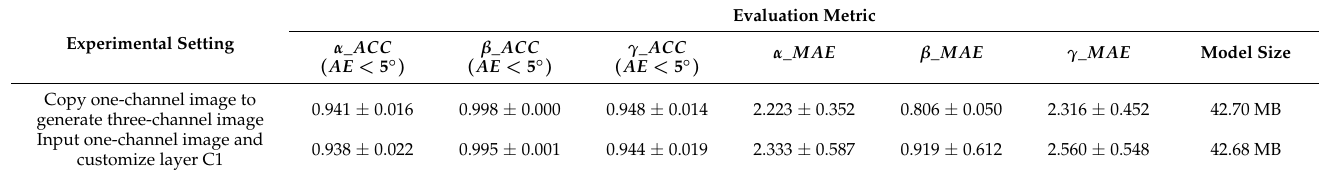
Table 4. The influence of the channel number of the input